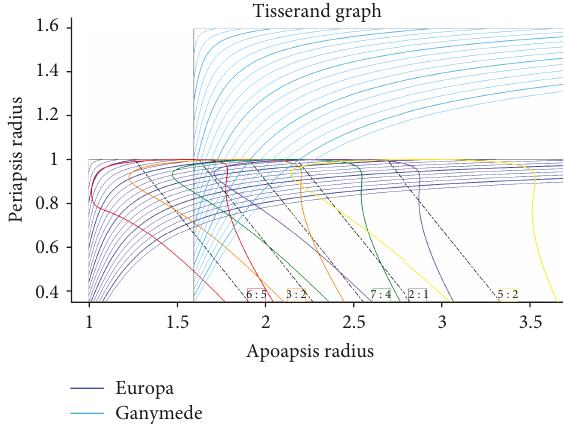
Figure 4: Tisserand graph for the Jovian planetary system. Contour lines of constant v ∞ , at steps of 2% of V m . Sample resonant orbits with Europa and corresponding maximum-deviation curves for a minimum fl yby altitude h π ,min = 30km are also depicted.